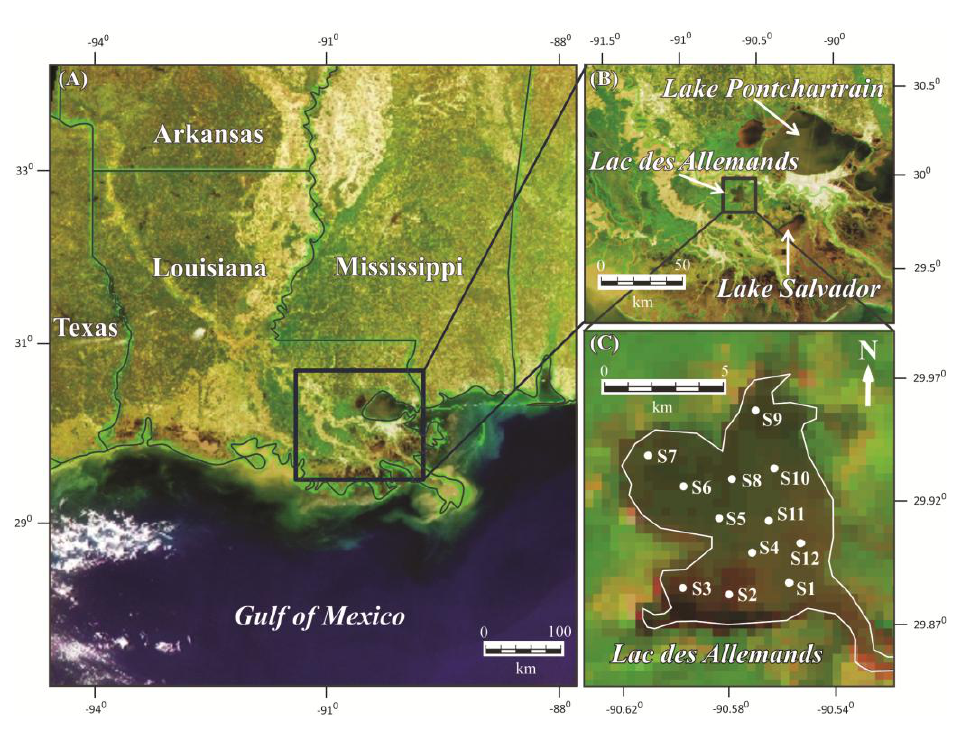
Figure 3. OCM image of 12 April 2007 showing the location of Lac des Allemands in southeastern Louisiana, with twelve sampling sites indicated